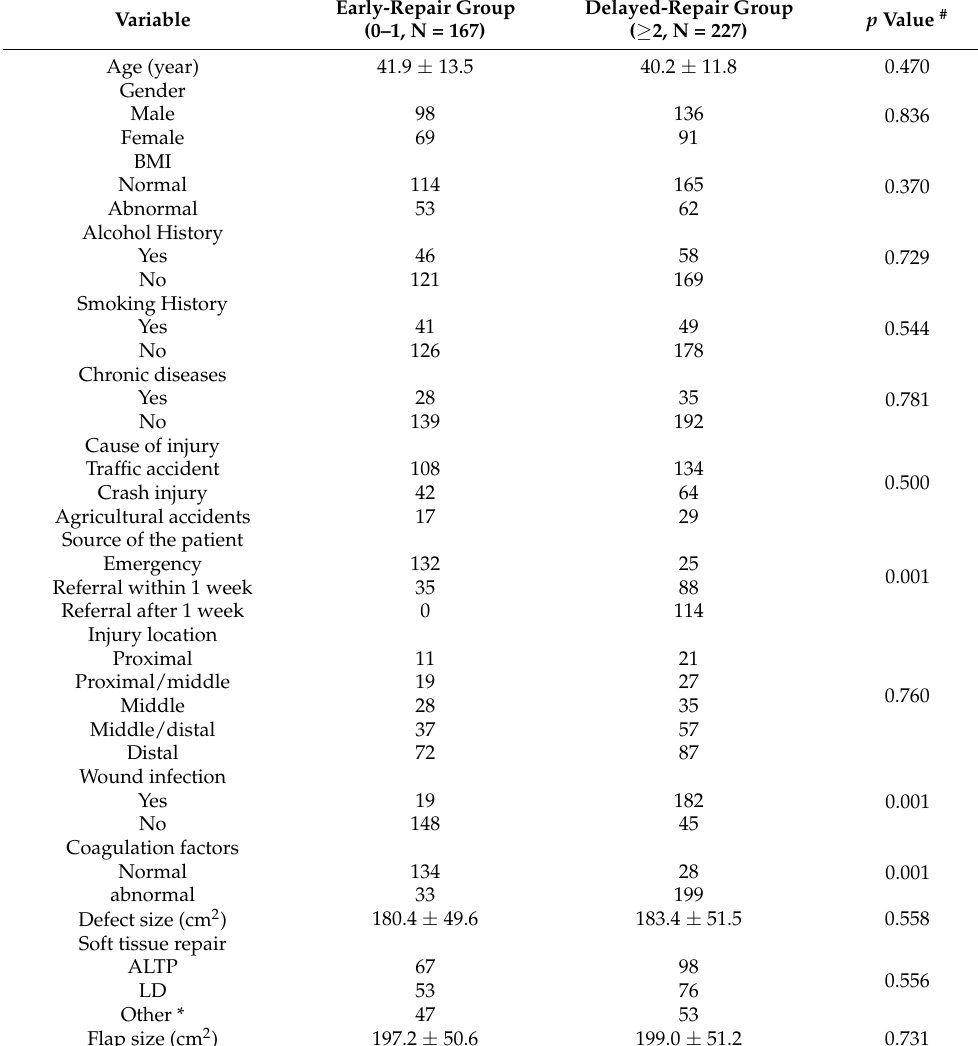
Table 1. Demographic